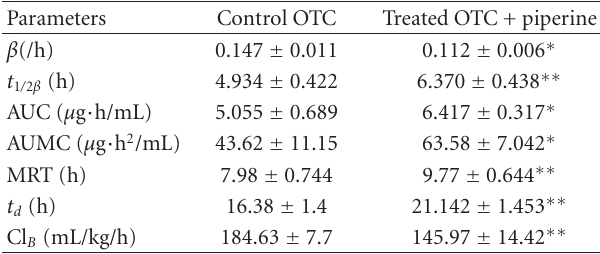
Table 9: Comparative pharmacokinetic parameters of oxytetra- cycline administered orally (10mg/kg) in control and P. longum treated birds [91].